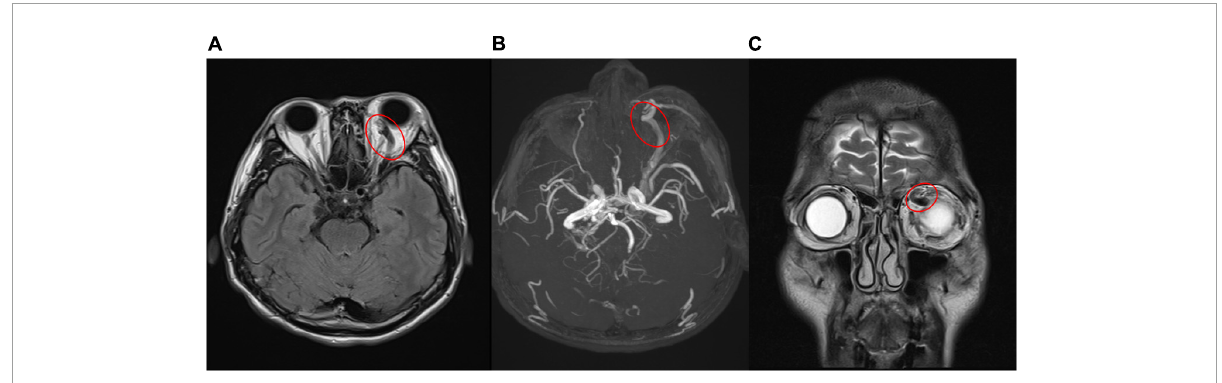
digital subtraction angiography confirmed right side direct CCF. After embolization of the fistula through the use of transarterial coil by the neuro-radiologist, the patient’s IOP gradually decreased after stopping anti-glaucoma medications. Furthermore, the extraocular movements of his right eye improved gradually. No more binocular diplopia presented. His left eye BCVA returned to 20/30 at that time, but he still had left eye proptosis and a relative afferent pupillary defect.